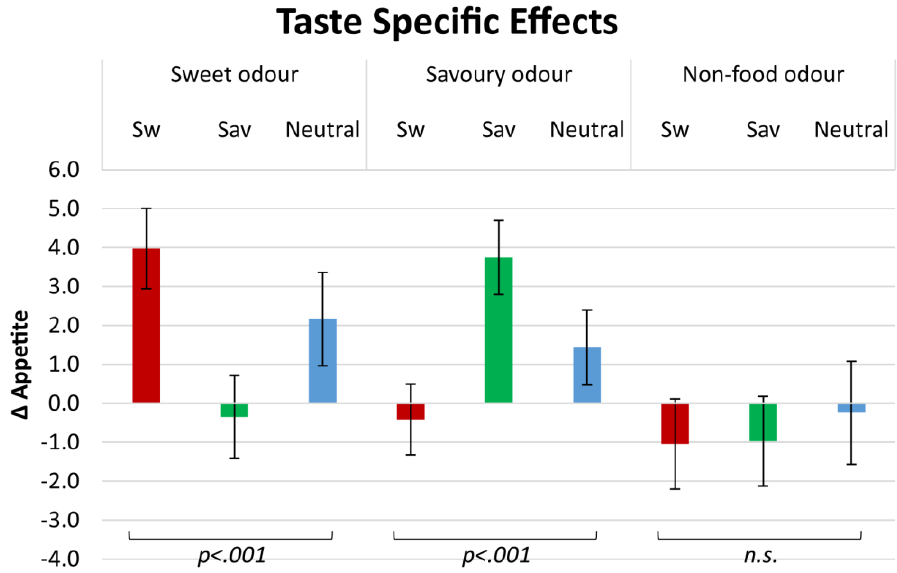
Figure 1. Δ Appetite (on 100mm VAS; appetite after smelling an odour minus appetite after smelling a baseline reference) for sweet (Sw), savoury (Sav) and neutral products after smelling sweet, savoury and non-food odours.